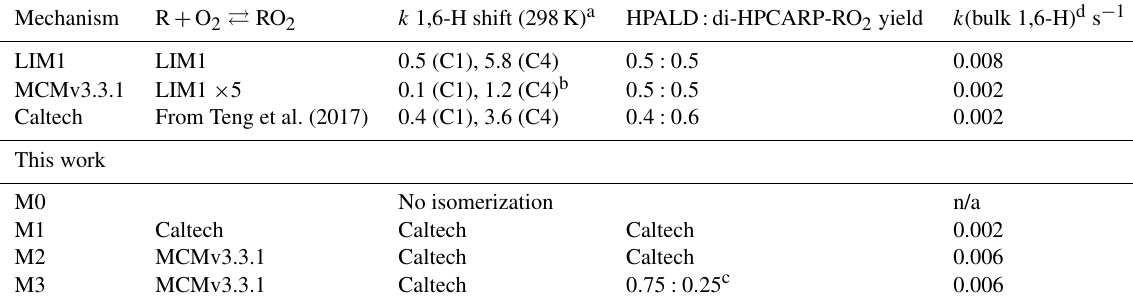
Table 2. Summary of the relevant differences for assessing the 1,6-H shift impact between available chemical models. All model versions within this work are based on the MCMv3.3.1 (accounting for chamber properties) with only specific rates and yields included in the table adapted from different studies. They also include the follow-up chemistry of di-HPCARP-RO 2 as theoretically investigated within this study. Mechanism R + O 2 (cid:29) RO 2 k 1,6-H shift (298K) a